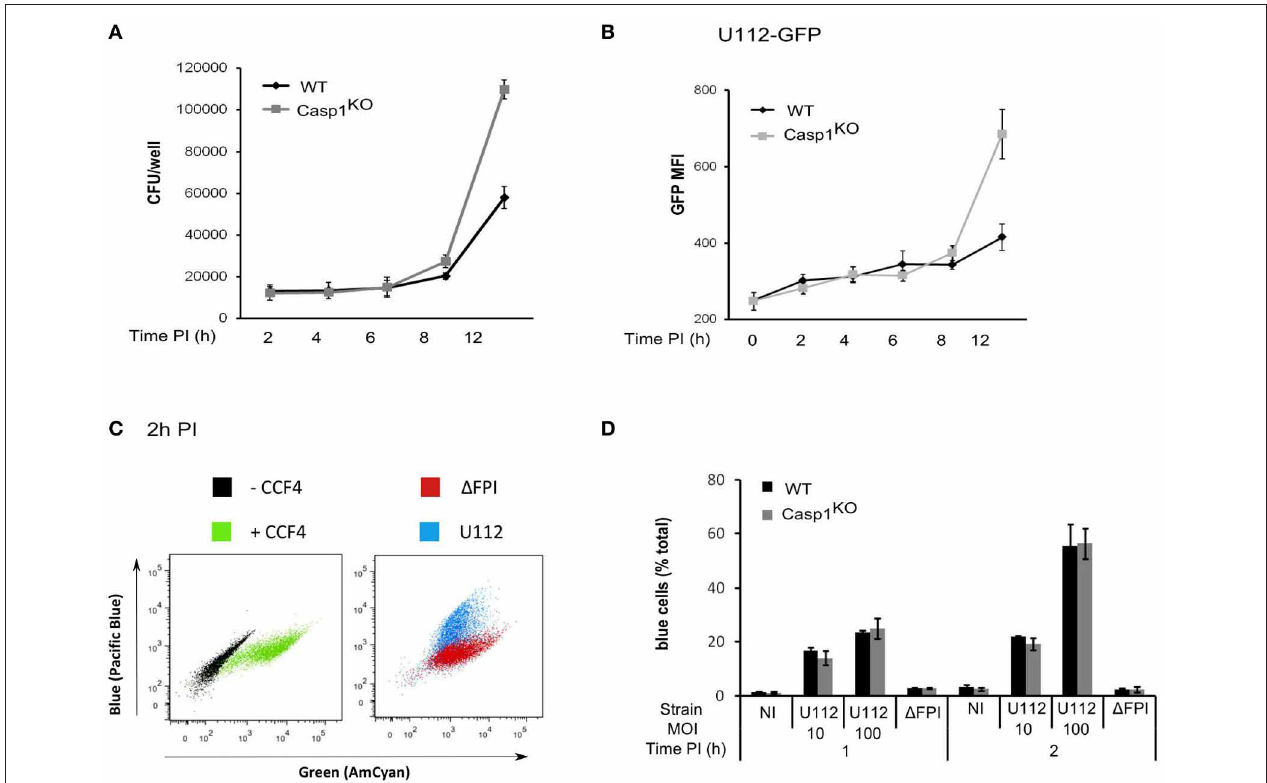
FIGURE 3 | The ASC/caspase-1-mediatednegativeregulation of AIM2 complexformation isnot due to regulationof bacterialentry, escapeor replicationin the host cytosol. (A–D) WT and Casp1 KO BMM, as indicated were infectedwith F. novicida U112or (cid:2) FPI mutant at a MOI of 10 for the indicated time. (A) Intracellular bacteria werenumeratedbyCFU assay. (B) Meanfluorescenceintensity(MFI)ofintracellularGFP-expressing F.novicida was determinedbyFACS. (C,D) At the indicated time PI, macrophageswere incubatedwith CCF4 for 1h and analyzedbyflowcytometry in presenceof